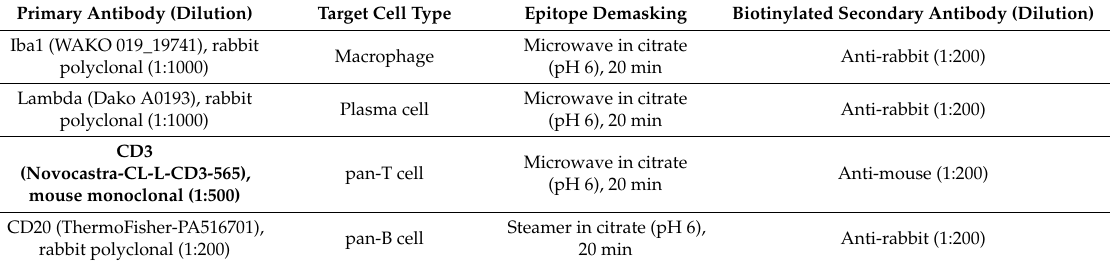
Table 1. Immunohistochemical protocols used to characterize types of inflammatory cell in skin lesion